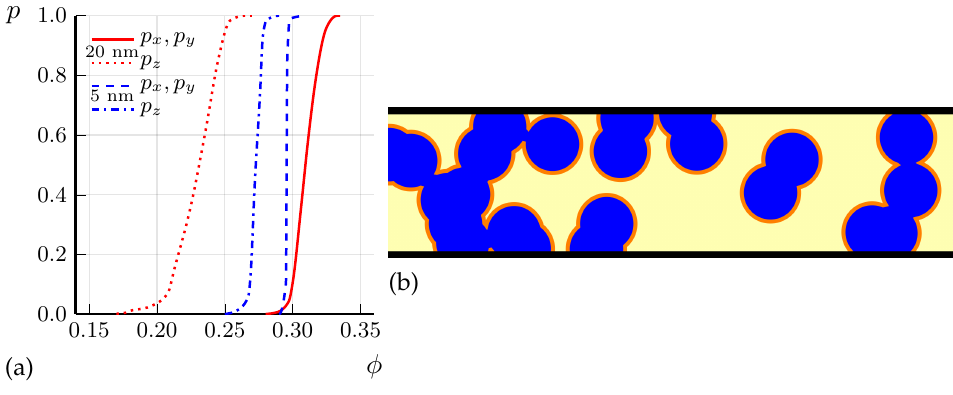
Figure 4. ( a ) Calculated probability p of current percolation along the in-plane x (solid and dashed curves) and the out-of-plane z axes (dotted and dash-dotted curves) via SC domains of spheroid shape with aspect ratio a z / a x = 0.62 as a function of SC volume fraction φ for two different domain heights d = d z = 20 nm (red curves) and 5 nm (blue curves) in a sample of dimensions 2 × 2 × 0.2 µm 3 ; ( b ) Two dimensional (2D) illustration showing that the current percolation along the sample thickness is easier than along the sample length. Circular SC islands (blue) with diameter d = 0.4 are randomly distributed inside a rectangular sample (yellow) of dimensions 7 × 2, forming SC channels between contact electrodes